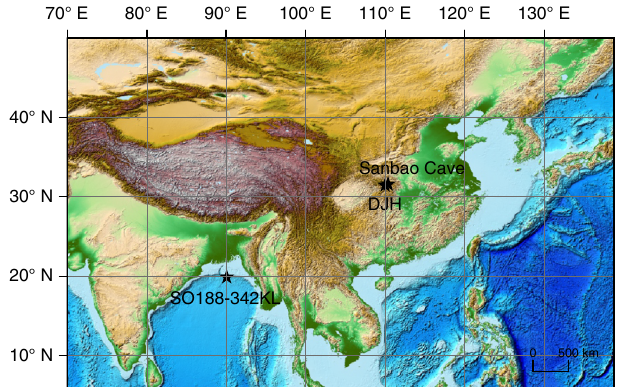
Fig. 1 Map of the sampling site. The Sanbao Cave and SO188-342KL site are also labeled. The public ETOPO1 data downloaded from https://ngdc. noaa.gov/mgg/global/relief/ETOPO1/image/ were used to plot the topographic map with the software of ArcGIS 9